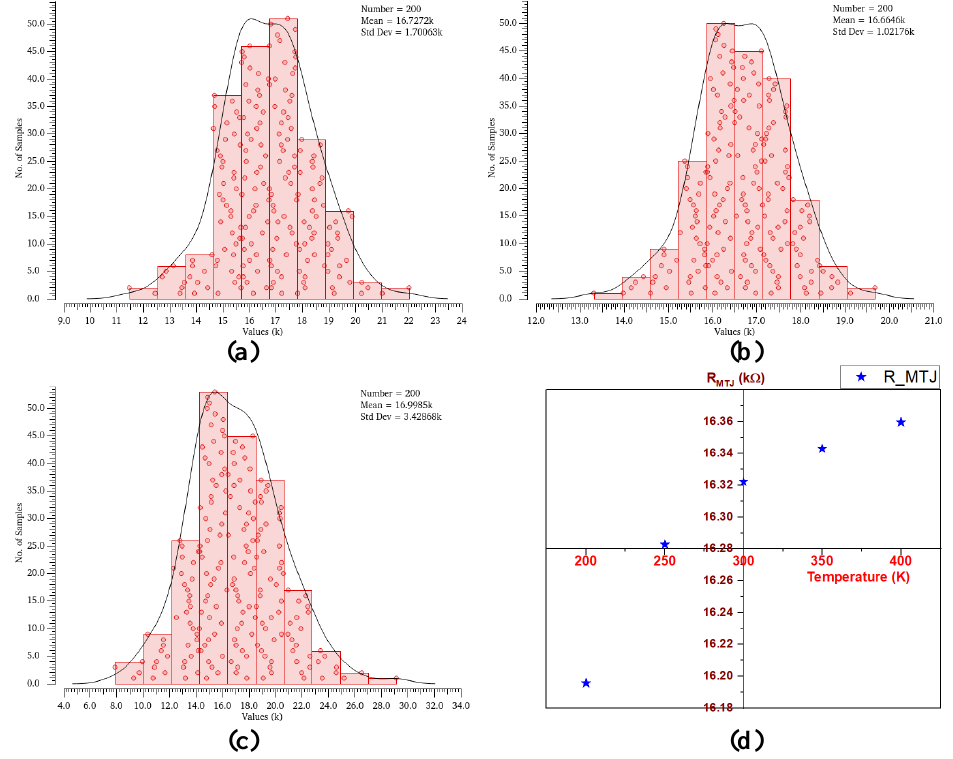
Figure 7. ( a – c ) Results of 200 Monte-Carlo simulations for variation in MTJ resistance in presence of different values of PV percentage. ( d ) MTJ resistance vs. temperature sweep. Table 2. Results of 200 Monte-Carlo simulations for average MTJ resistance value under various PV. PV ( TMR